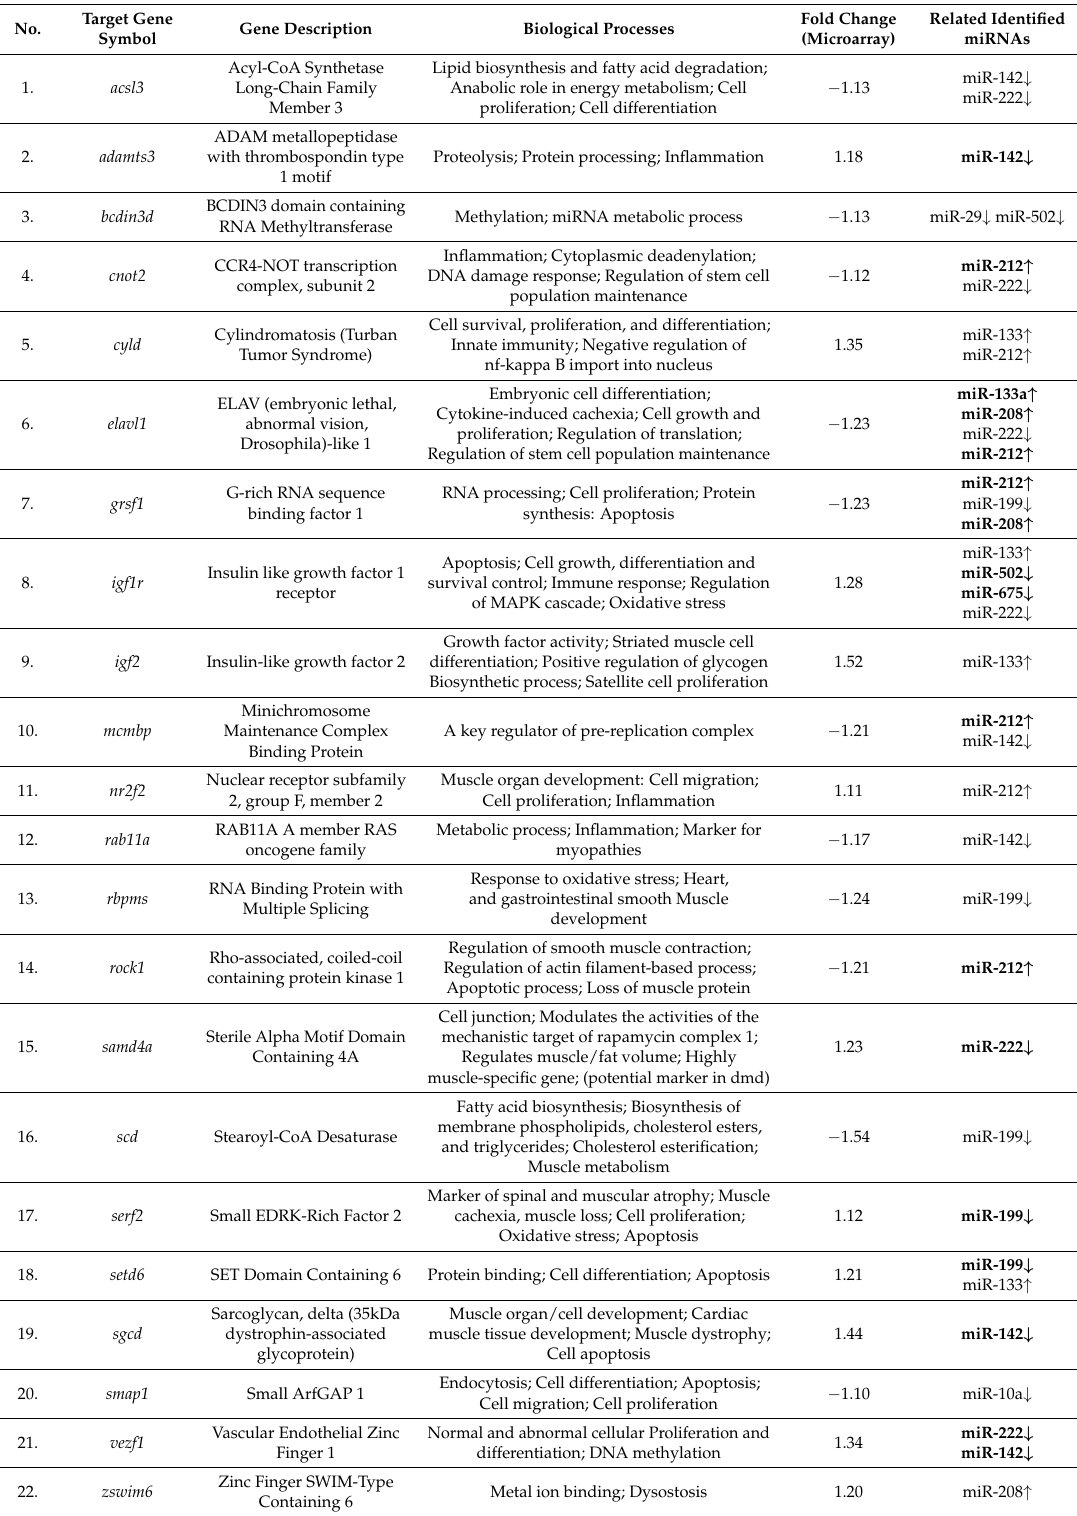
Table 5. DET and related processes together with corresponding